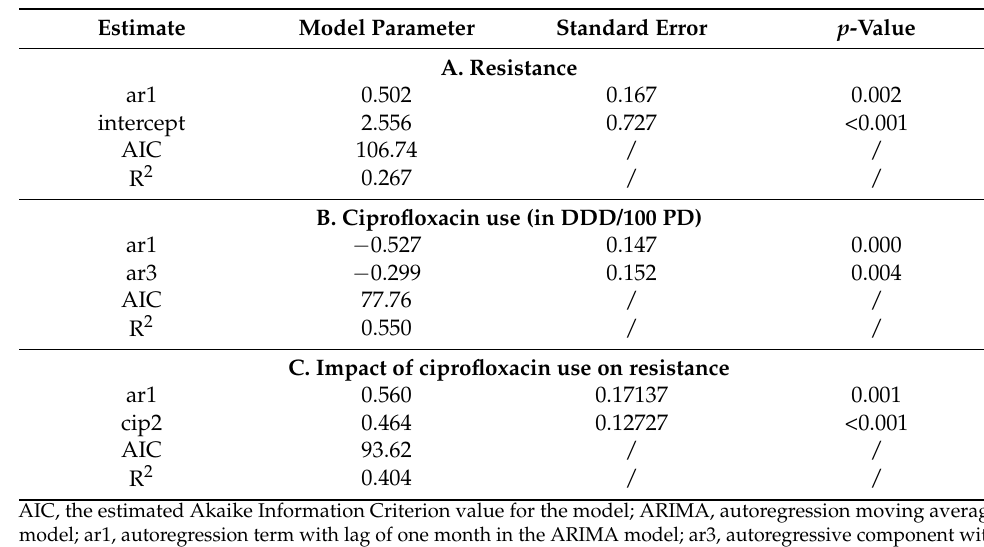
Table 5. ARIMA models for ciprofloxacin-resistant P. aeruginosa ( A ) and ciprofloxacin use ( B ). Dynamic regression model for the association between ciprofloxacin-resistant P. aeruginosa and hospital ciprofloxacin use ( C ).